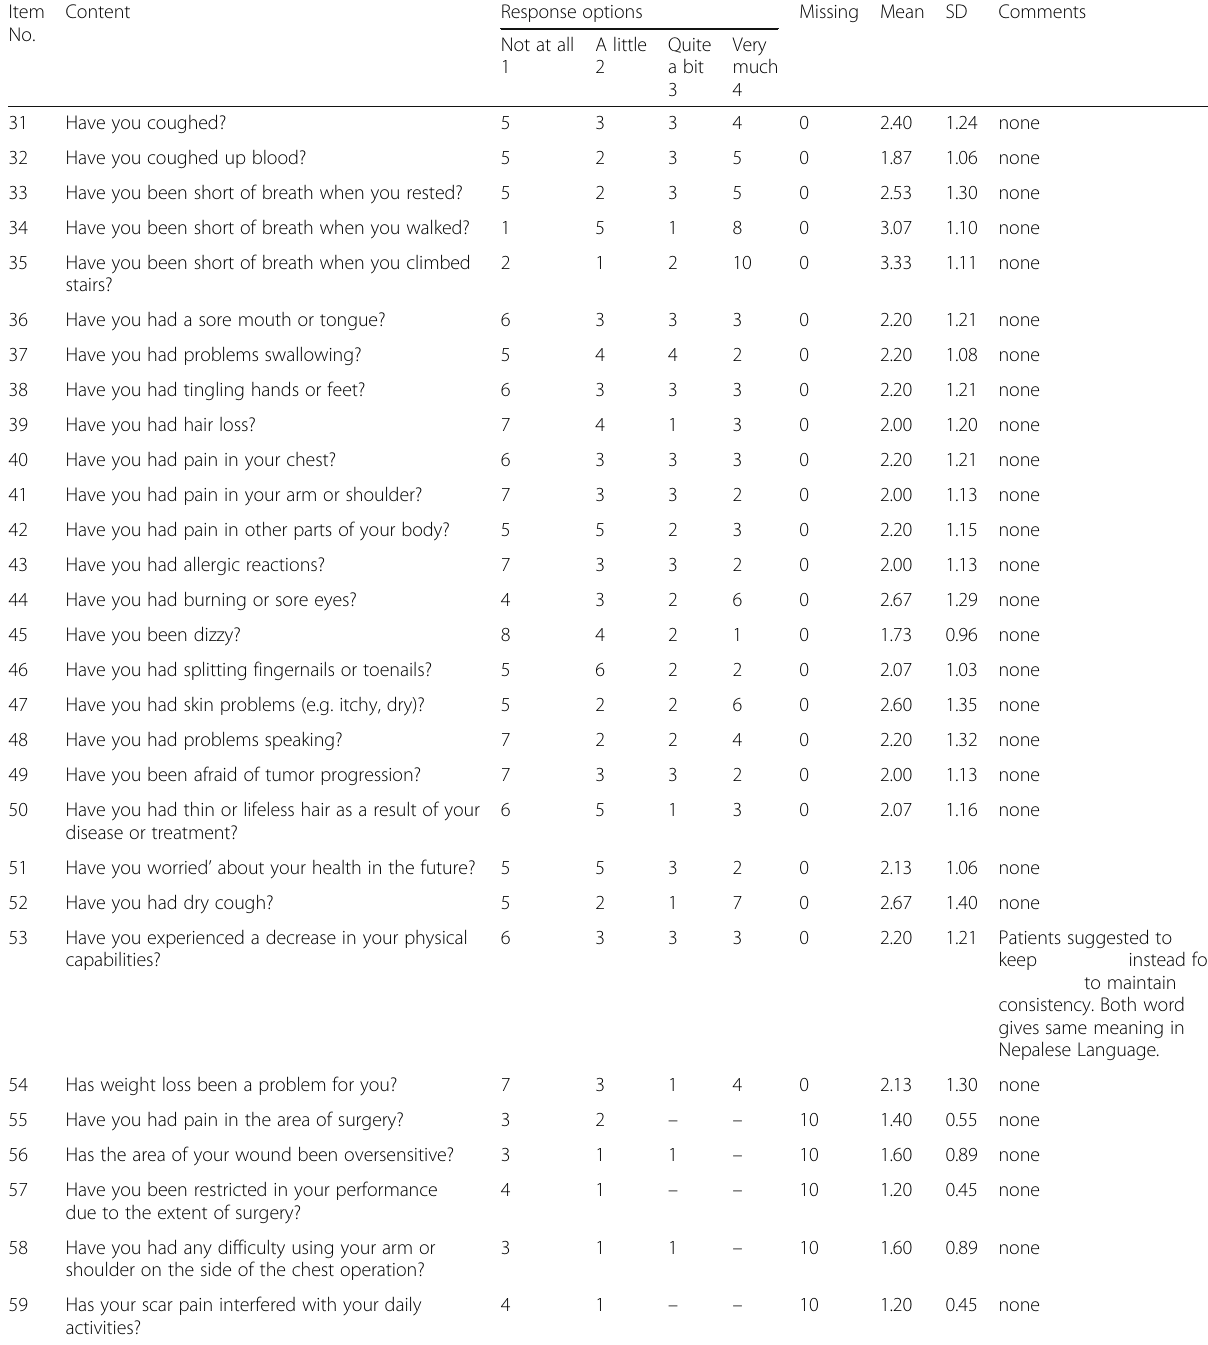
Table 2 Pilot testing: Descriptive statistics and comments by patients Item